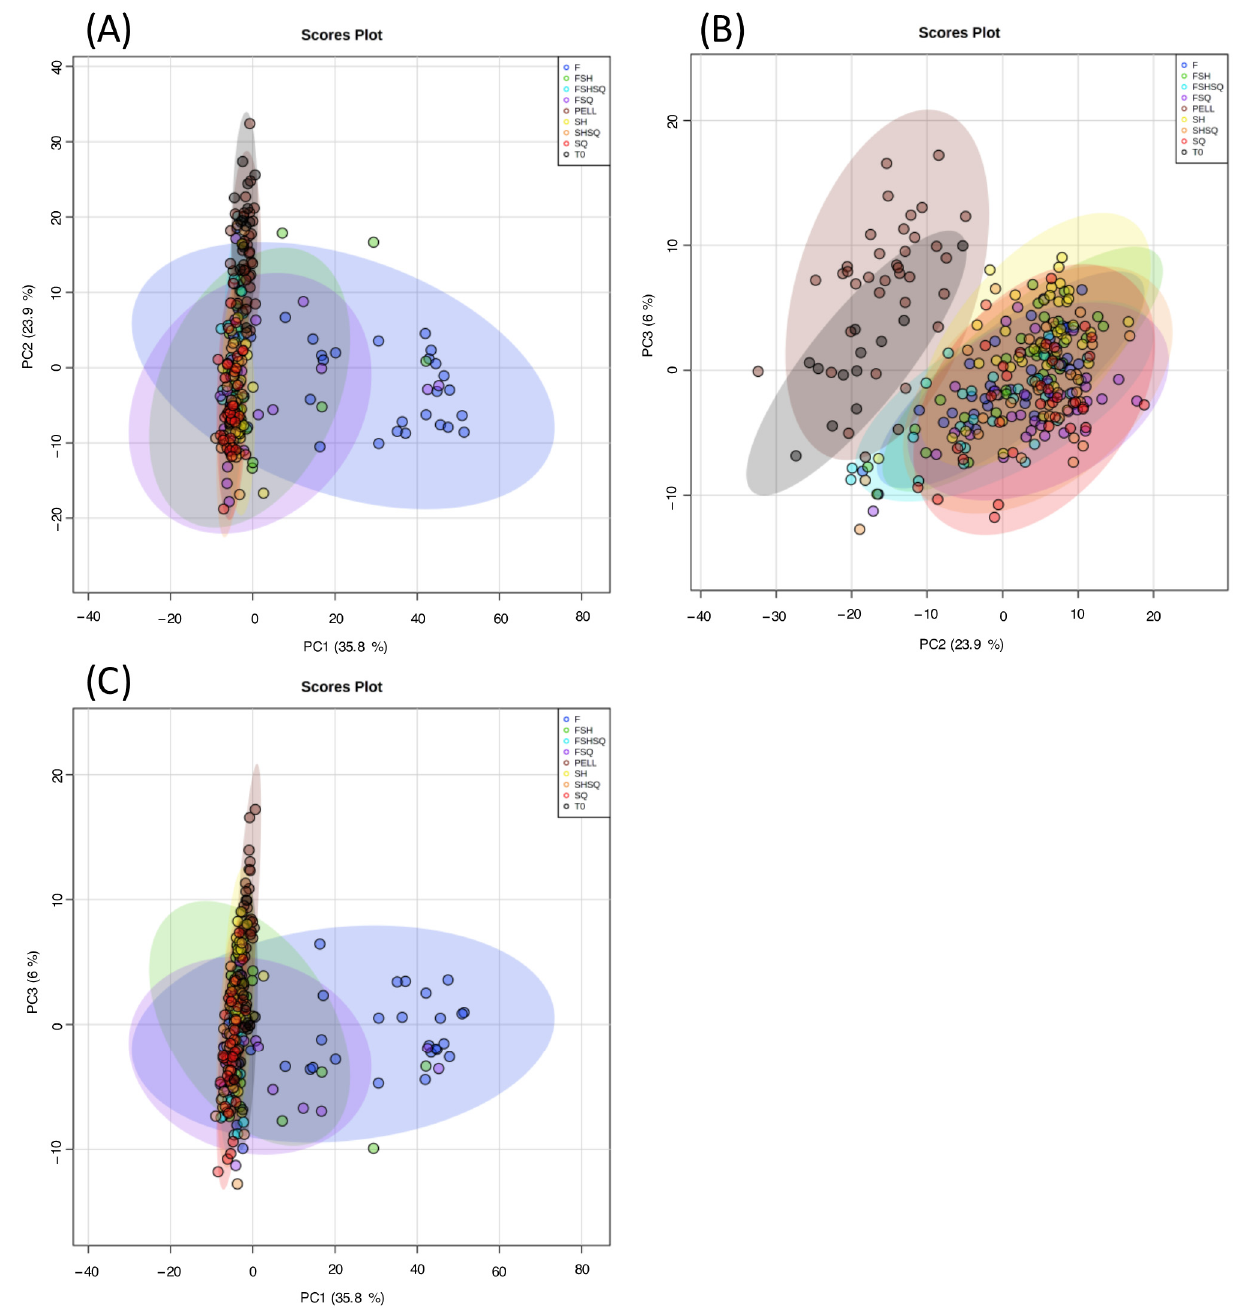
Figure 1. Unsupervised PCA score plots from red drum liver tissue extracts for the 8 diets evaluated in this study and the conditioning diet (T0). ( A ) PC1/PC2 score plot. ( B ) PC2/PC3 score plot. ( C ) PC1/PC3 score plot. The explained variances along the different principal components are shown in brackets. Shaded areas represent the 95% confidence regions. T0, initial time point (conditioning diet, same composition as PELL); F, fish diet; FSH, fish + shrimp diet; FSHSQ, fish + shrimp + squid diet; FSQ, fish + squid diet; PELL, pelleted commercial fishmeal-based diet; SH, shrimp diet; SHSQ, shrimp + squid diet; SQ, squid diet.